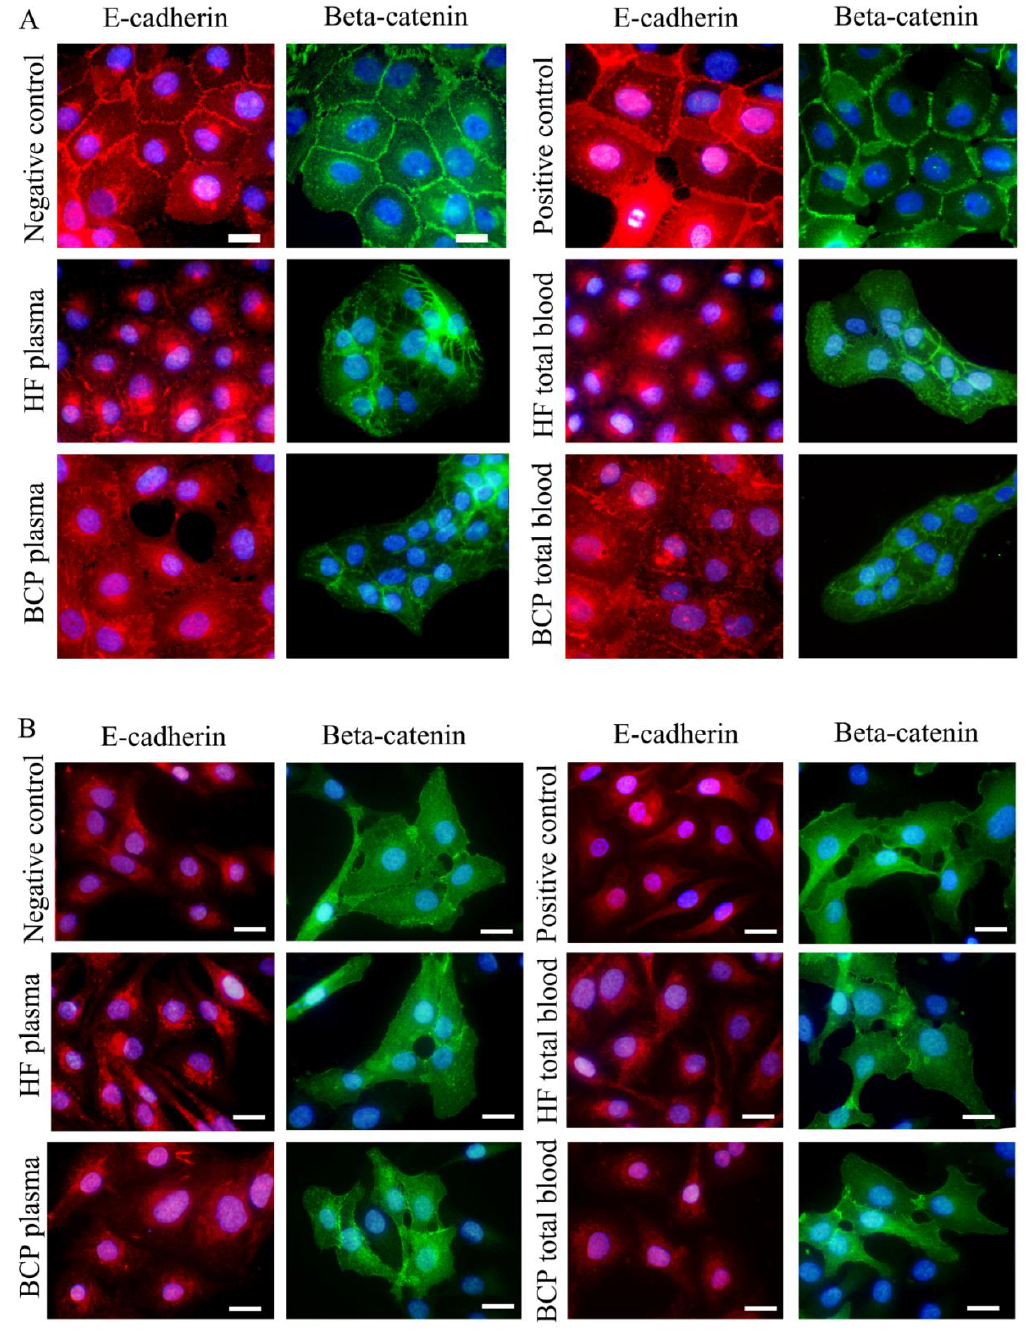
Figure 6. Theinfluenceofexosomesonthemorphologyofcell-celladhesionsofcellsbyimmunofluorescent staining of E-cadherin (red color) and β -catenin (green color). Cell nuclei stained with DAPI (blue). Figure 6. The influence of exosomes on the morphology of cell-cell adhesions of cells by Experimental conditions are described near the pictures. Bar is 20 µ m. MCF10A cells ( A ), SKBR-3 cells ( B immunofluorescent staining of E-cadherin (red color) and β-catenin (green color). Cell nuclei stained with DAPI (blue). Experimental conditions are described near the pictures. Bar is 20 µm. MCF10A cells ( A ), SKBR-3 cells ( B ).